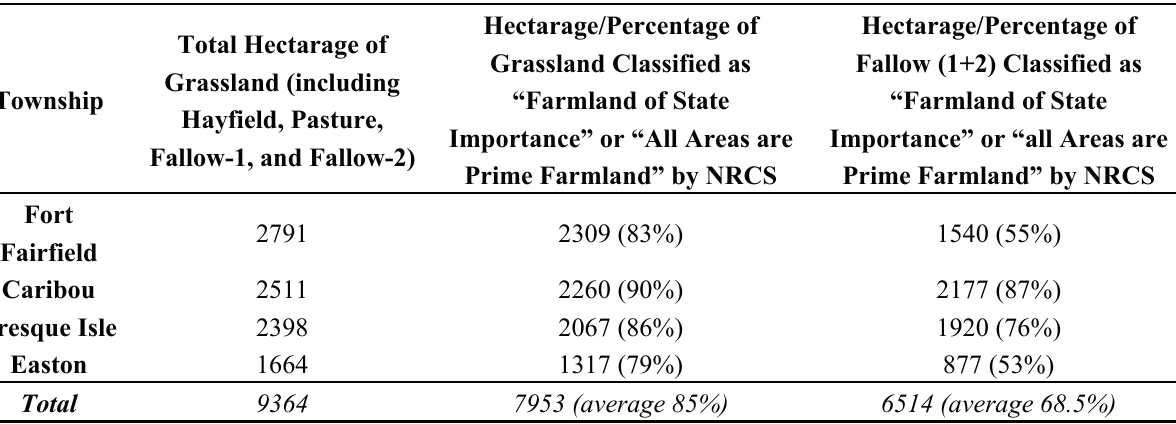
Table 3. Hectarage of grasslands classified as “farmland of state importance” or “all areas are prime farmland” by